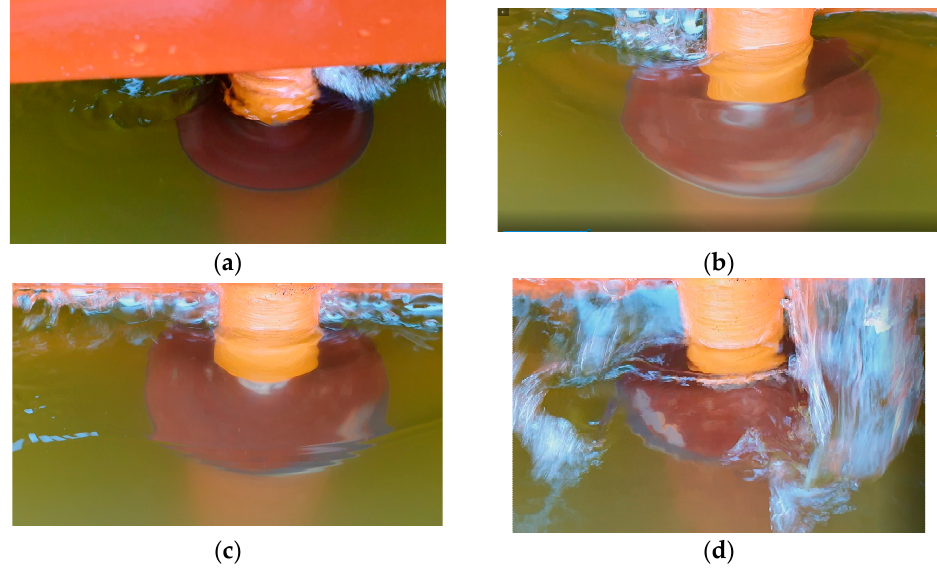
Figure 4. Flow around RC1: ( a ) model velocity 0.5 m/s, RC2 rotational speed 200 RPM, ( b , c ) model